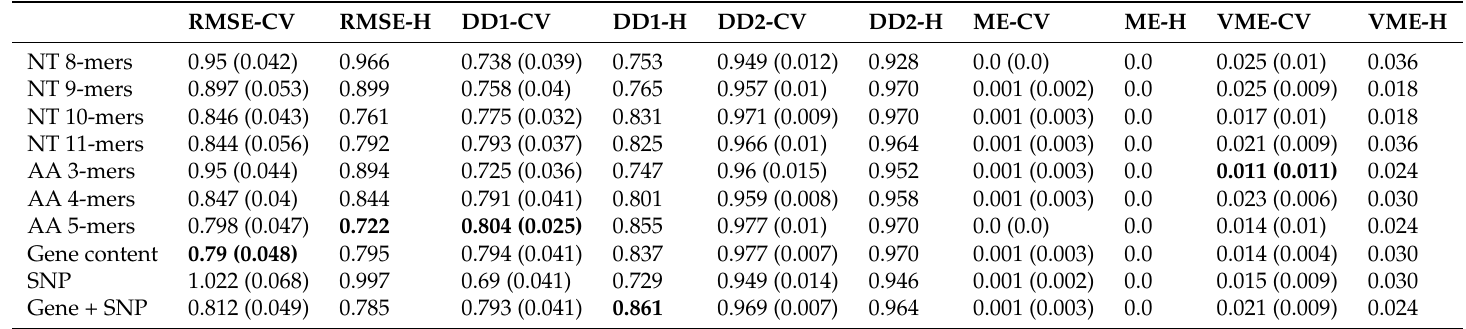
Table A40. K. pneumoniae